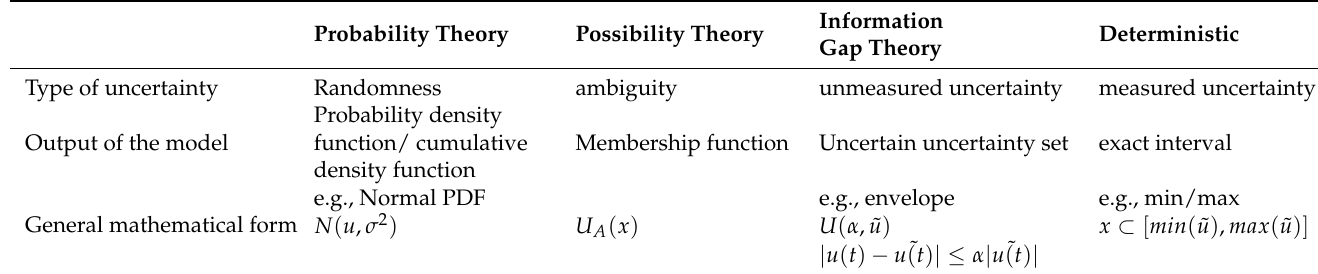
Table 7. Summary of the uncertainty models.